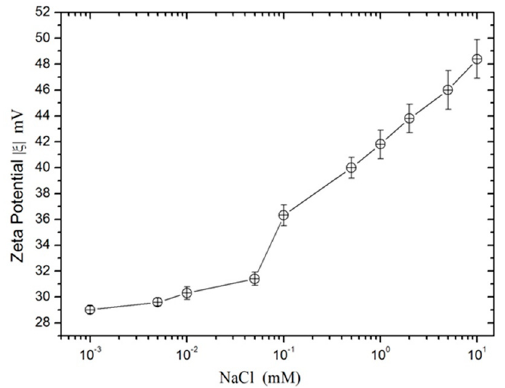
Figure 4. Zeta potential in aqueous dispersions at various salt concentrations. The particle concentration was 0.01%, and the particle size was 535 nm.